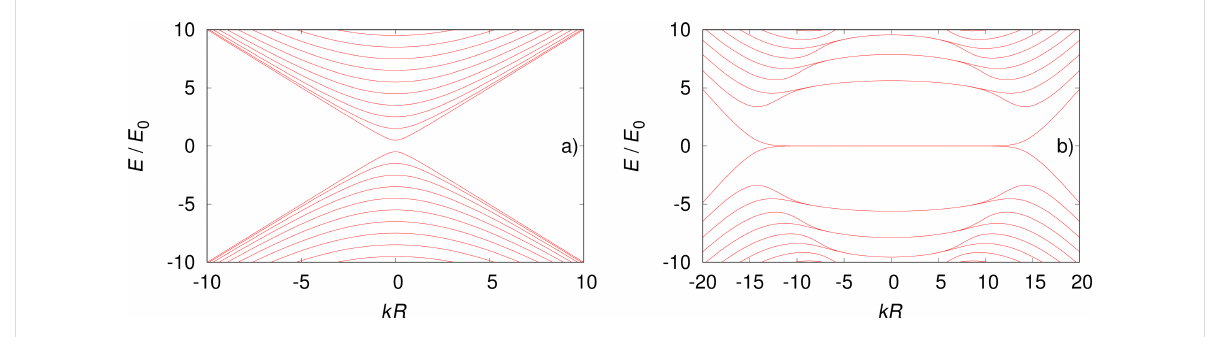
Figure 1: Energy spectra for a) B = 0 and b) B = 4.0 T. Note that the system is gapped at B = 0 but not at B = 4.0 T. We used v F = 10 5 m/s and R = 50 nm for the current calculations, which gives E 0 = ≈ 1.3